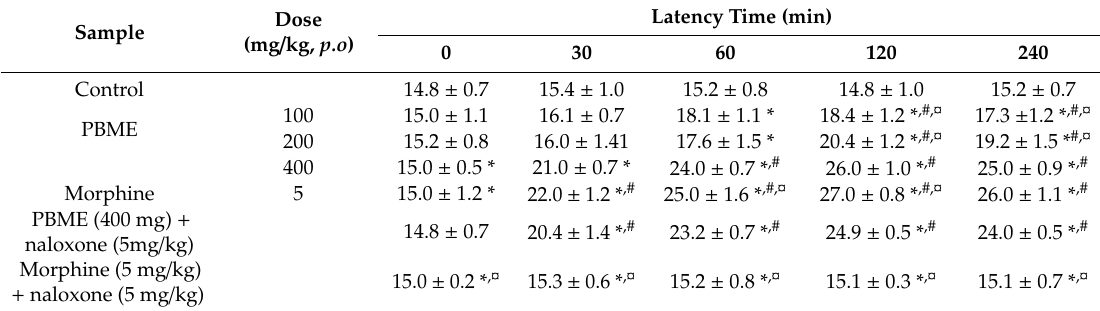
Table 2. Time course e ff ect of P. benghalensis leaves’ extracts on the thermal model.